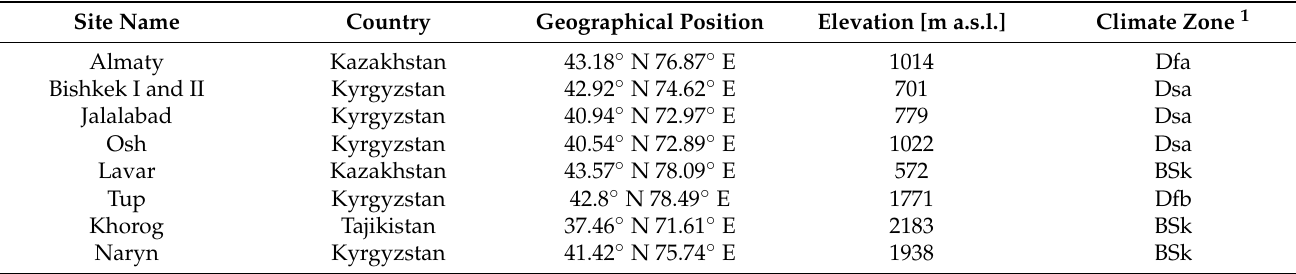
Table 2. List of sites with their geographical location, elevation, and climate